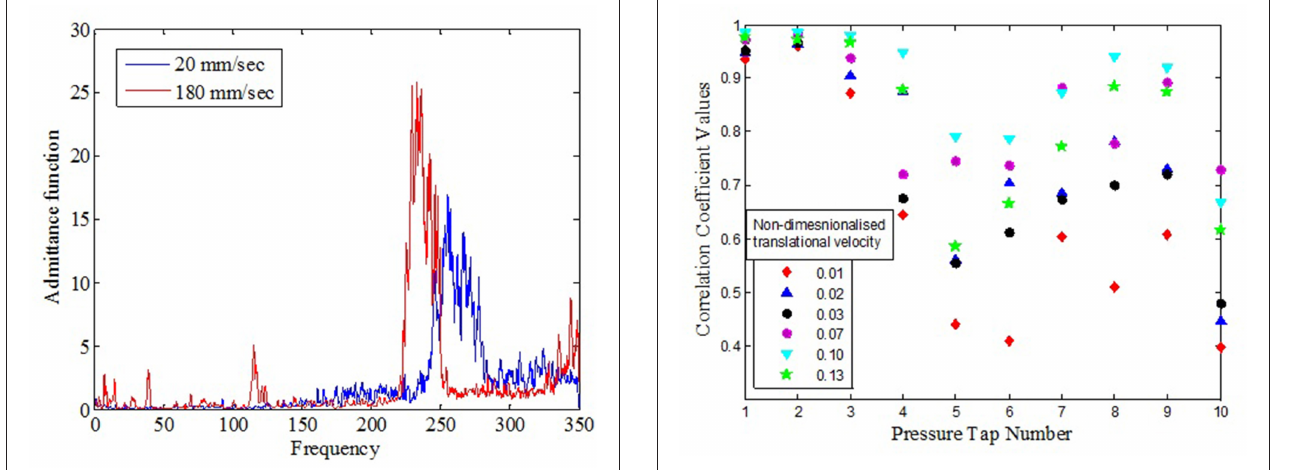
more vulnerable to tornado effects compared to the side walls.